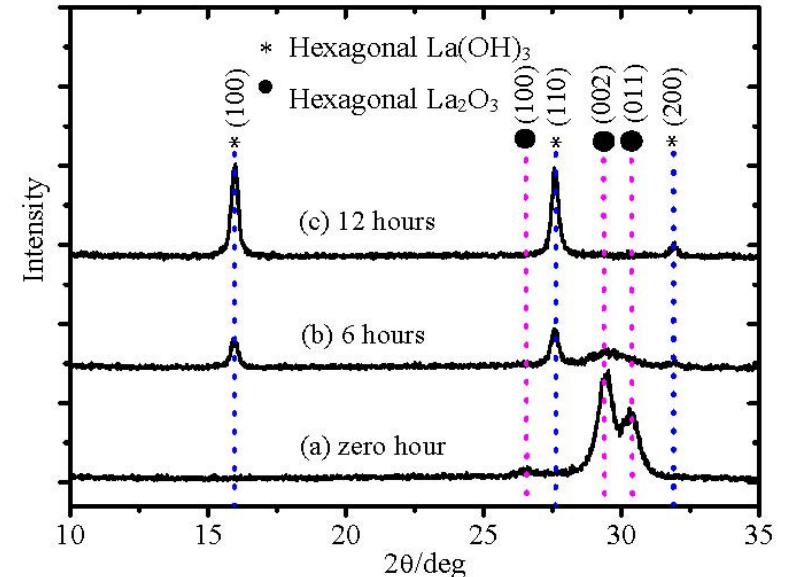
Figure 1. XRD patterns of La ( a ) zero hours; ( b ) 6 hours and ( c ) 12 hours.